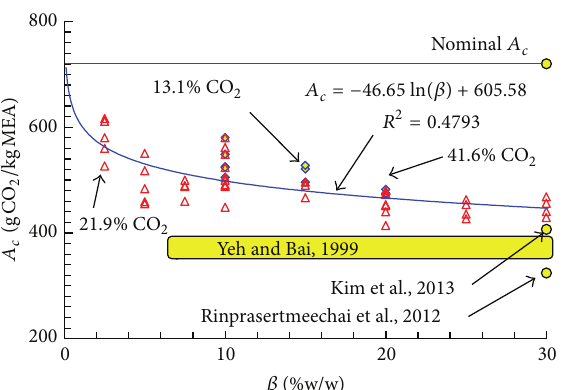
∗ with 95 % of confidence.